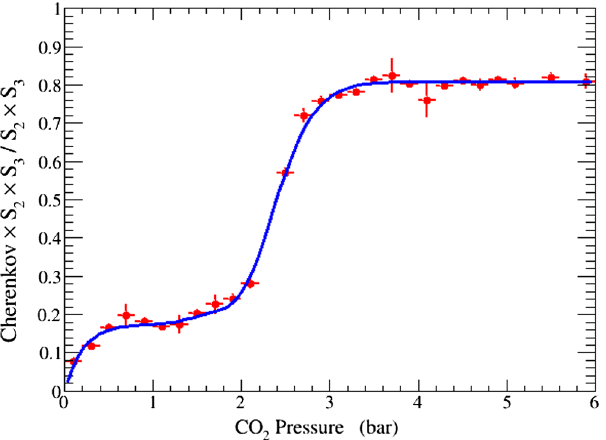
FIG. 16. Pressure scan demonstrating the particle identification using two Cherenkov counters, for the case of 3 GeV =c . The first plateau around 4 bar corresponds to pions and muons. The second plateau around 1 bar corresponds to positrons. Setting therefore one Cherenkov to 4 bar and the second to 1.2 bar, pions/muons and positrons are tagged.